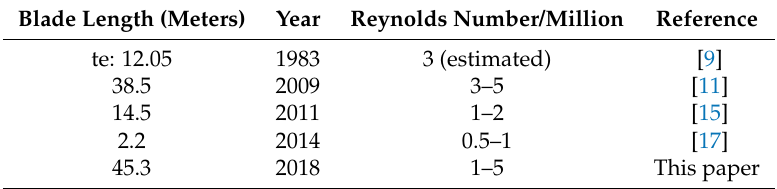
Table 2. Summary of field experiments on wind turbine (WT) blades dedicated to investigations of the laminar–turbulent